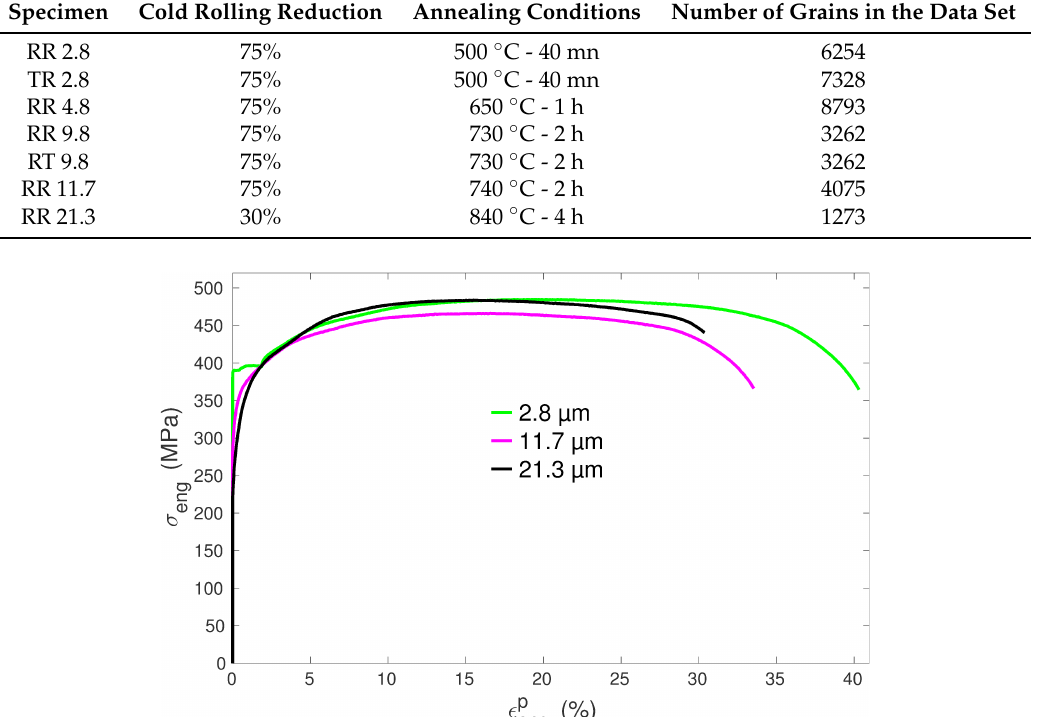
Table 1. Preparation conditions and some metallurgical data of the seven specimens.